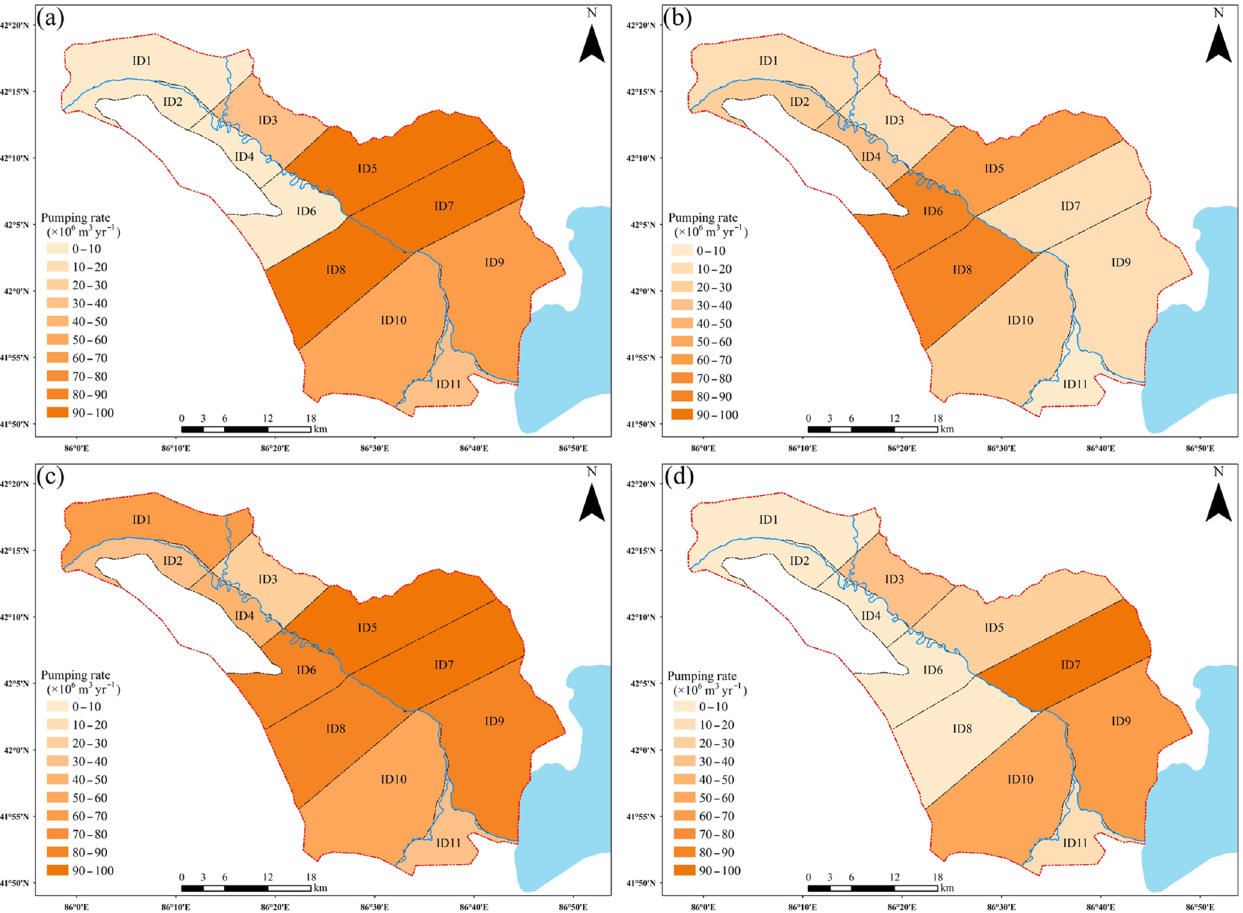
Figure 9. The spatial distribution of the pumping rates in the 11 irrigation districts for the four selected schemes: (a) Solution 4; (b) Solution 7; (c) Solution 5; and (d) Solution